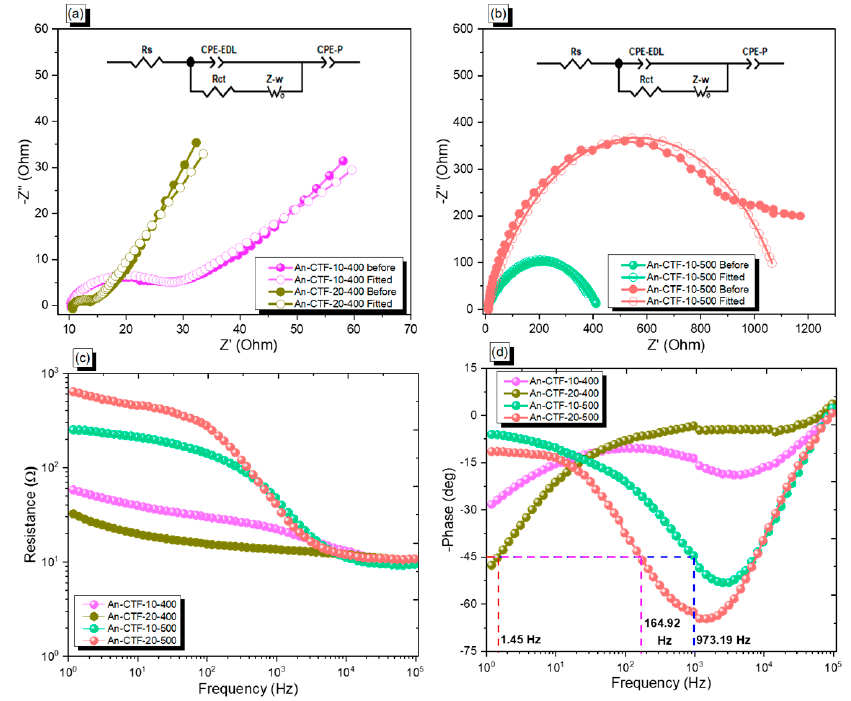
Figure 10. ( a , b ) Nyquist plots, ( c ) Bode magnitude plots, and ( d ) Bode phase plots of An-CTF-10-400, An-CTF-20-400, An-CTF-10-500, and An-CTF-20-500 cells.